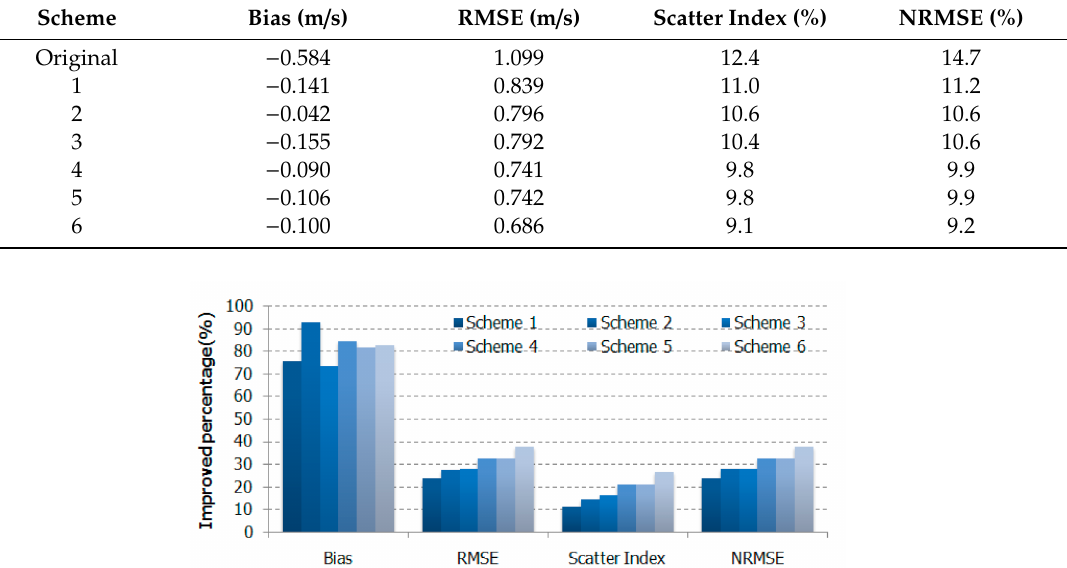
Table 4. Validation of wind speed calibration DNN schemes.